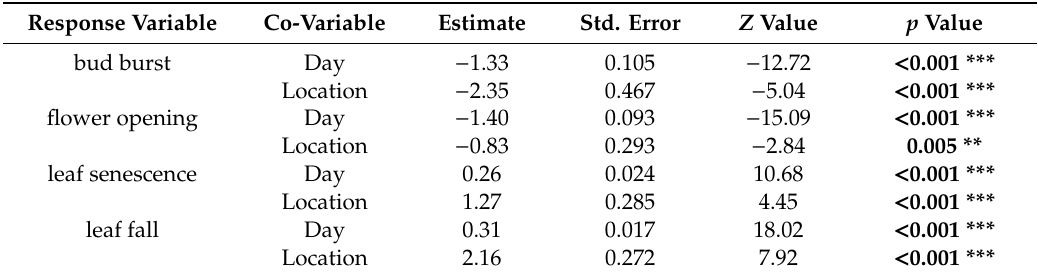
Table 3. Model statistics for the response variables leaf bud burst, flower opening, leaf senescence and leaf fall. Dentergem is the standard level of the variable location to which Semmerzake is compared with. Day is the co-variable indicating the day of observation of the respective phenophase, demonstrating that plants enter further phases of development on later days.